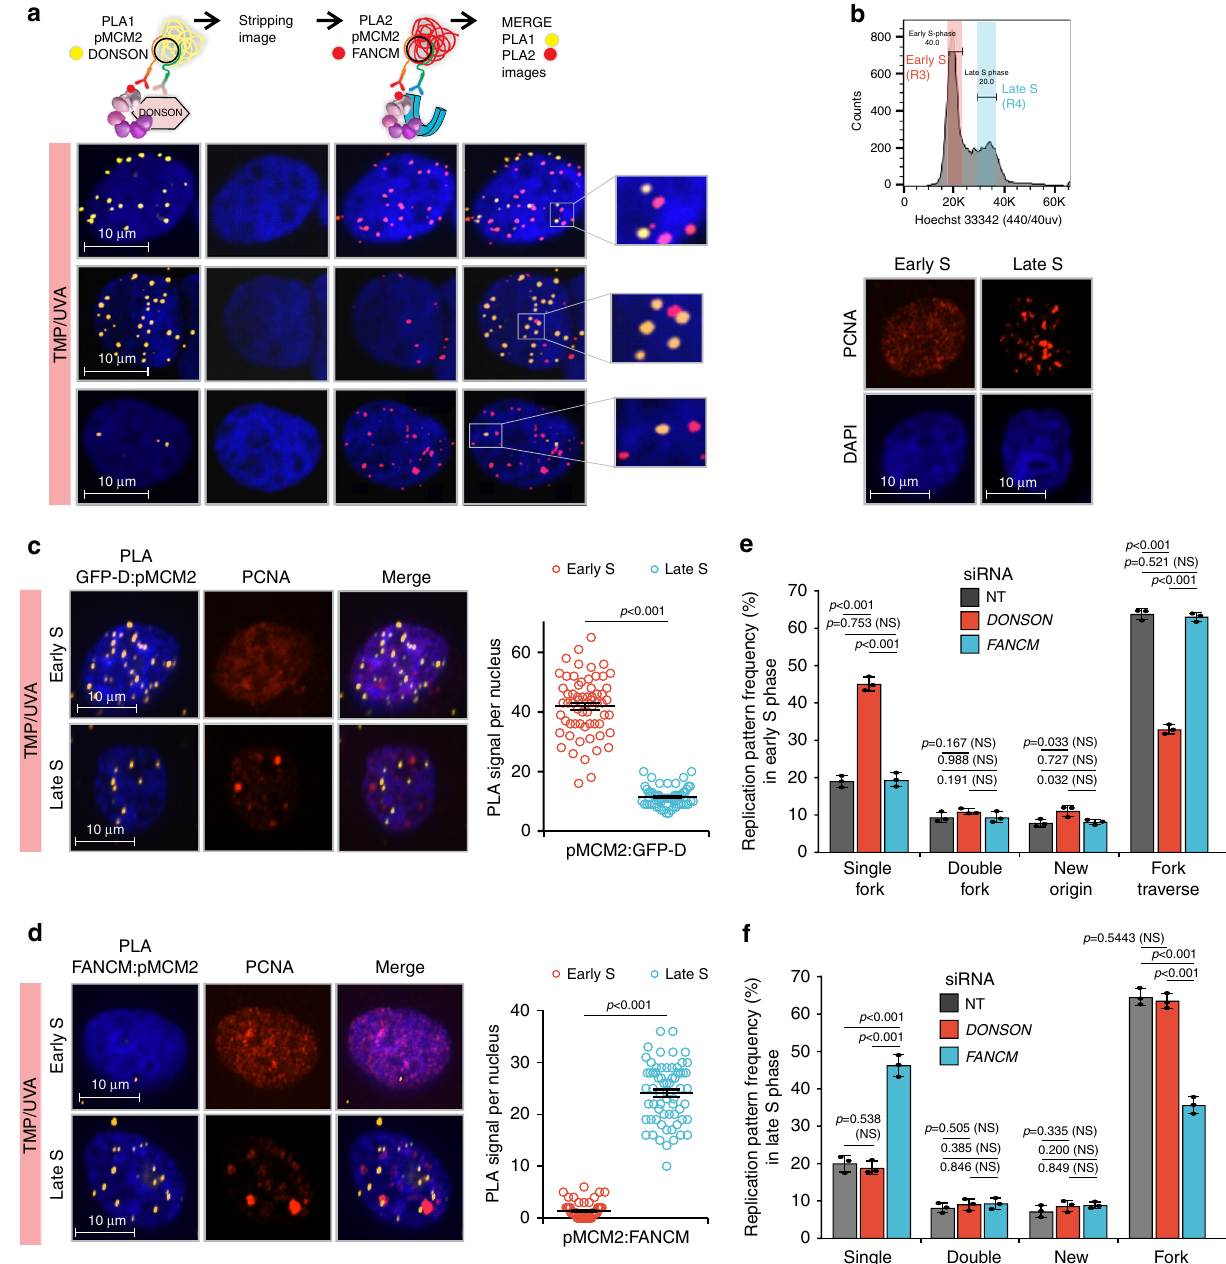
Fig. 3 DONSON and FANCM replisomes are active in different stages of the S phase. a Analysis by sequential PLA of GFP-DONSON: pMCM2S108 complexes and then FANCM: pMCM2S108, in GFP-DONSON expressing cells exposed to TMP/UVA. After the fi rst PLA, the cells were photographed ( fi rst column of images) and the antibodies and PLA product stripped (second column). The second PLA was performed, and the cells re-imaged (third column). The fourth column shows a merge of both images after image registration in the xyz planes using the DAPI signal. Examples are shown of cells with strong signals from both fi rst and second PLA, or strong signals from the fi rst but infrequent from the second, or weak from the fi rst and strong from the second. The signals from the two PLA do not colocalize. b Early and late S phase fractions were isolated from sorted cells. The PCNA staining pattern from each fraction. c GFP-D: pMCM2S108 PLA in sorted early and late S phase cells. Scored nuclei: GFP-D: pMCM2S108 of early S phase = 62, late S phase = 60, from three biological replicates. Data are mean ± s.e.m. d FANCM: pMCM2S108 PLA in sorted early and late S phase cells. Scored nuclei: FANCM: pMCM2S108 of early S phase = 63, late S phase = 64, from three biological replicates. Data are mean ± s.e.m. e , f In fl uence of DONSON and FANCM on patterns of replication encounters with ICLs in early and late S phase cells. Cells were treated with siRNA against DONSON or FANCM, exposed to Dig-TMP/UVA and pulsed with nucleoside analogues as in Fig. 1a. Cells were sorted, and fi ber patterns from early and late S phase analyzed. Data are mean ± s.d.. For PLA experiments ( c , d ), a two-sided Mann – Whitney rank-sum test was used, for replication pattern experiments ( e , f ) a two- sided unpaired t test was used, to determine if differences were statistically signi fi cant. NS: not signi fi cant: P > 0.05. Source data are provided as a Source Data fi